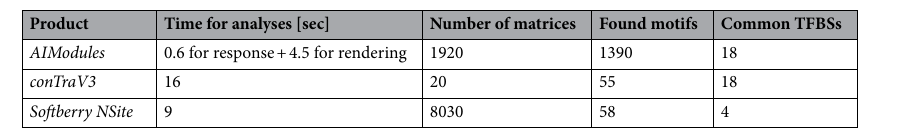
Table 2. Tool comparison: Performance Statistics for found motifs and common